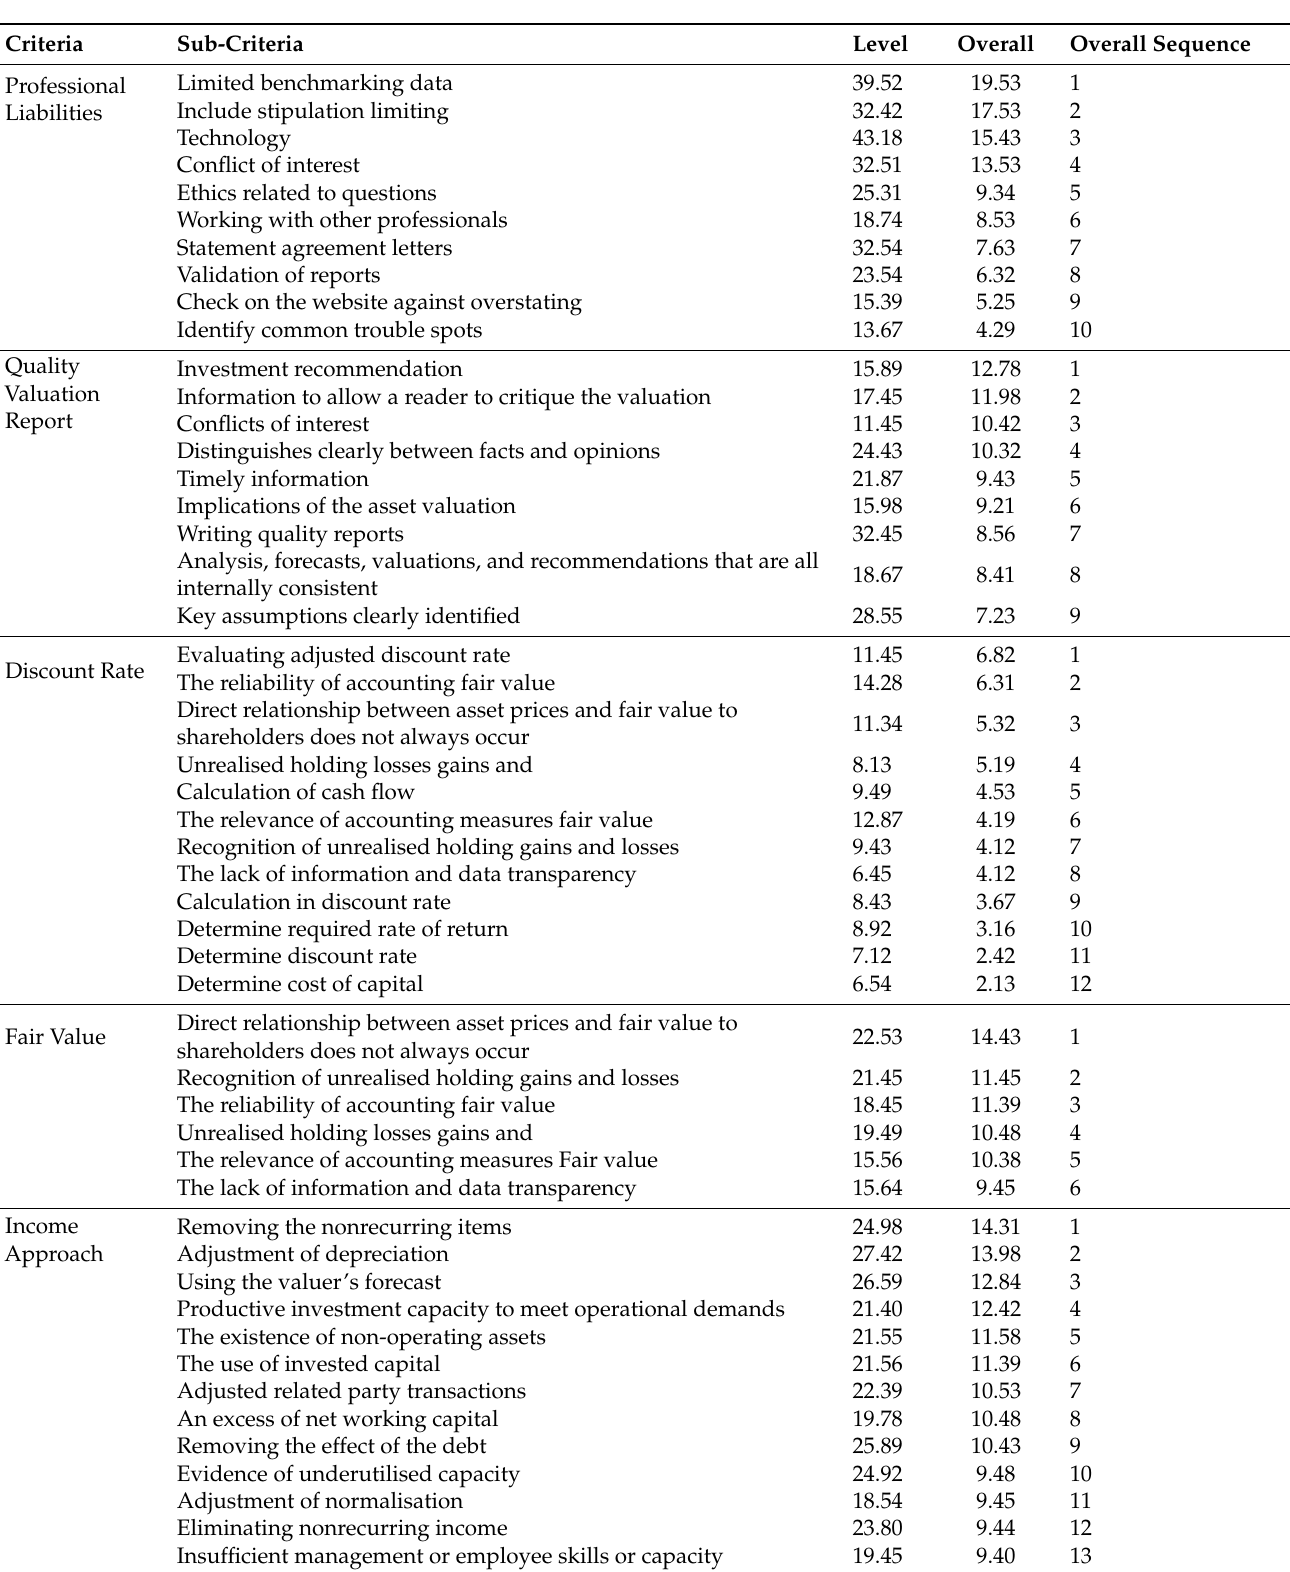
Table 5. Relative Weights of Major Criteria and Minor